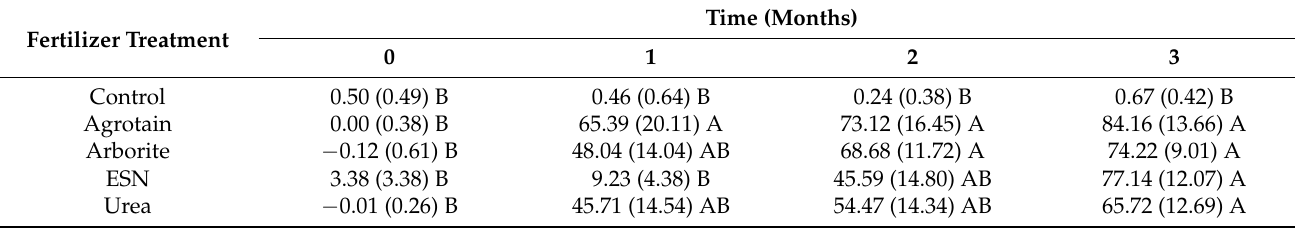
Table 4. Responses of δ 15 N (‰) of black walnut crop tree leaves to fertilization treatments and time. Table entries are means ( ± standard error of the mean) for each fertilizer treatment × time combination ( n = 8). Means throughout the table marked with the same letters did not differ significantly ( α = 0.05).